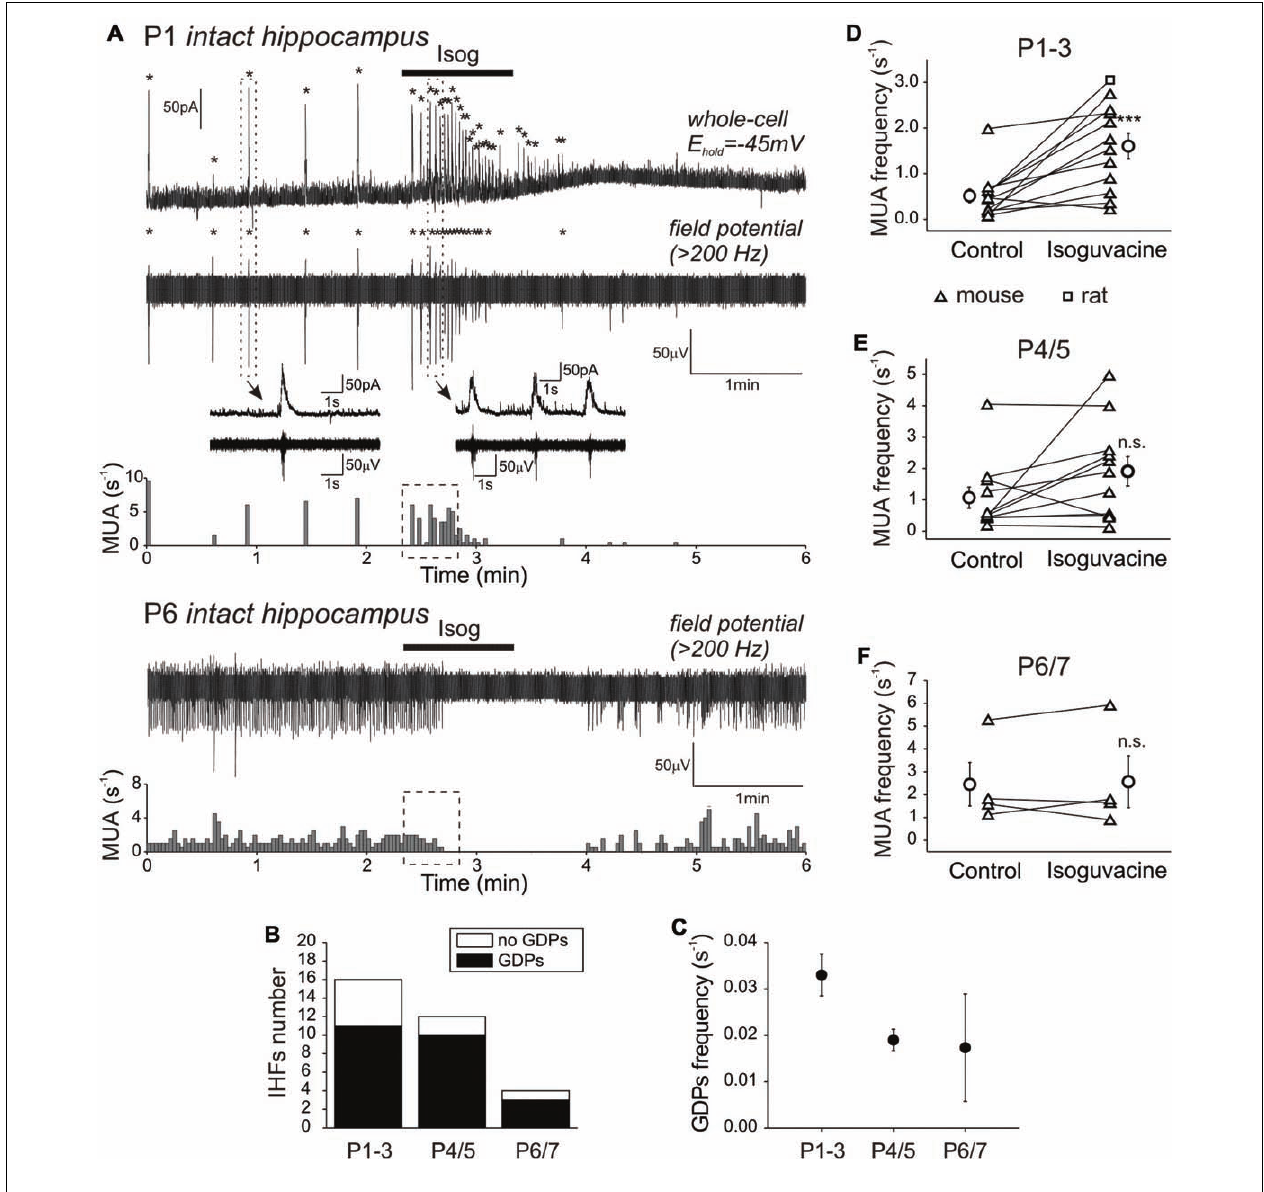
in the insets on expanded time scale. (B) Summary plot of GDPs presence in the intact hippocampi recorded on P1–P7. (C) Age-dependence of GDPs frequency in the intact hippocampi during the first post-natal week. (D–F) Pooled data on MUA level in control and during isoguvacine application (in the box-outlined area on A ) in the intact hippocampi of P1–3 (D) , P4–5 (E) , and P6–7 (F) mice (triangles) and rats (squares). Each pair of data points correspond to individual intact hippocampus. Separate circles show mean values with